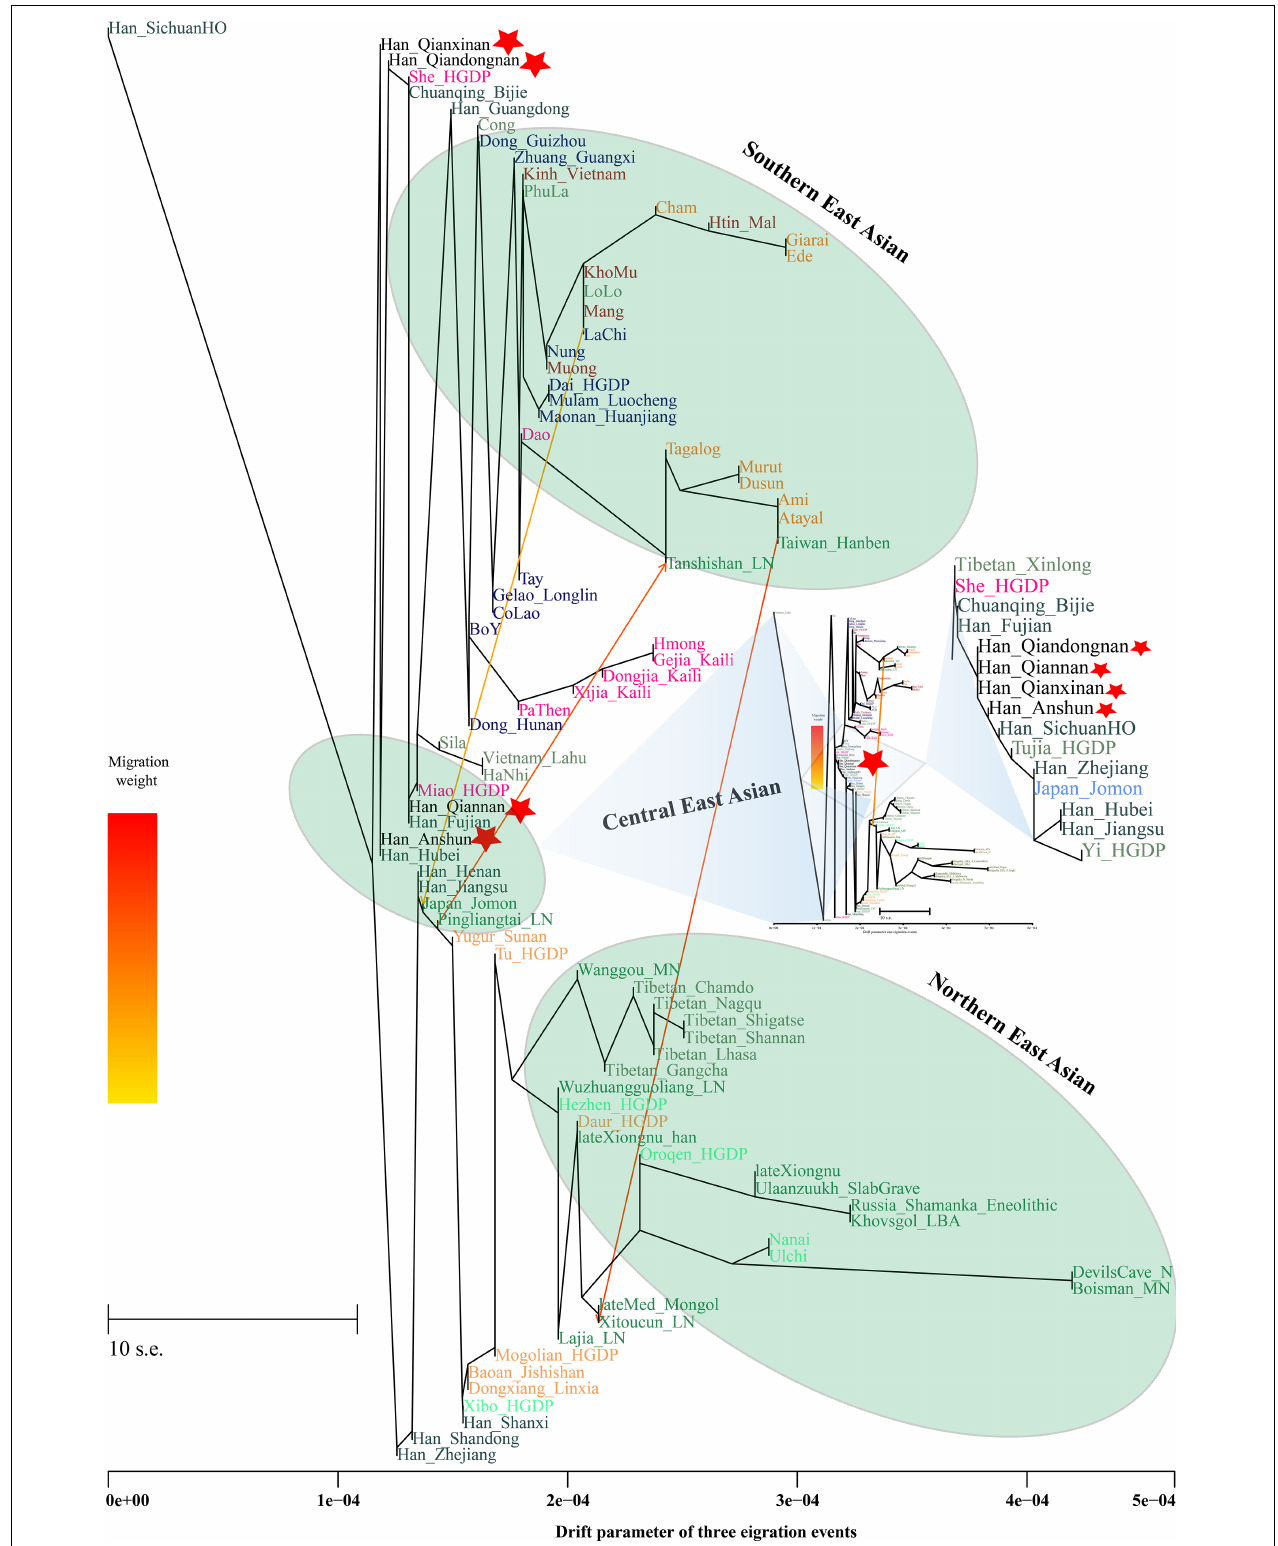
FIGURE 5 | TreeMix-based phylogenetic relationship between four Guizhou Hans and other modern and ancient East Asians with three migration events. Different populations from one language families/groups were color-coded.